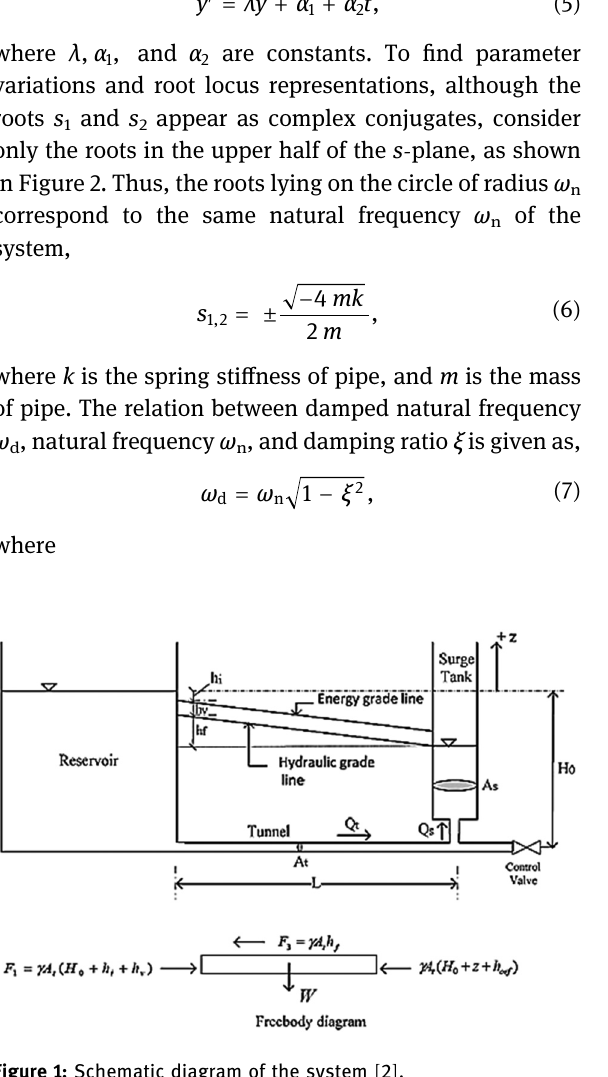
Figure 2: Roots in the upper half of the s - plane. Figure 1: Schematic diagram of the system [ 2 ]